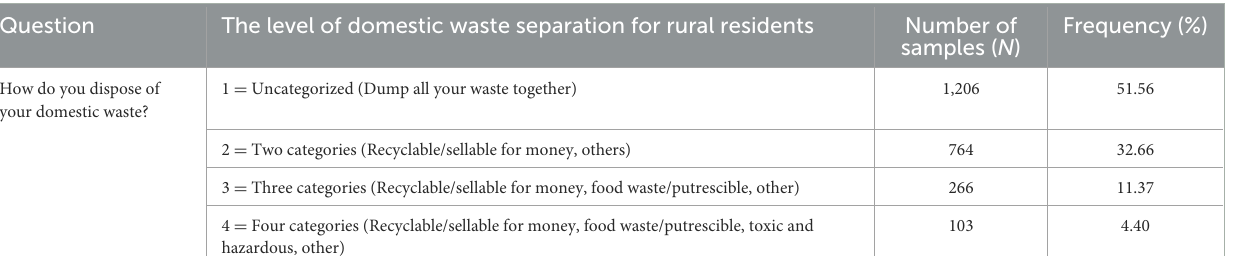
TABLE 1 Statistics on the level of domestic waste separation for rural